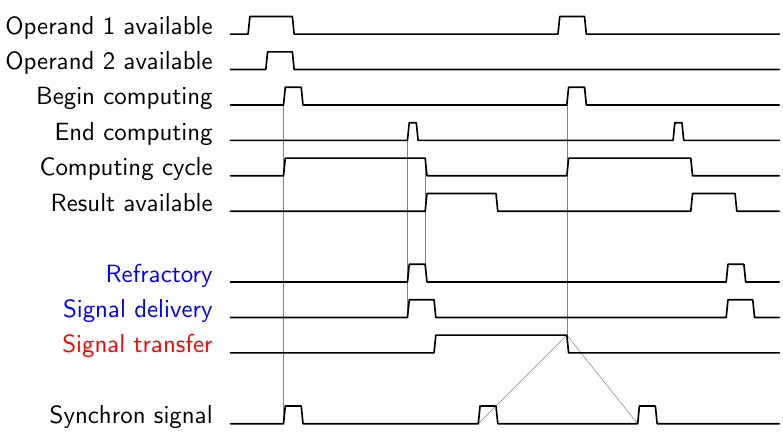
Figure 2. Timing relations of von Neumann’s complete timing model, with data transfer time in chained operations; synchronization becomes an issue as the physical size of the computing system